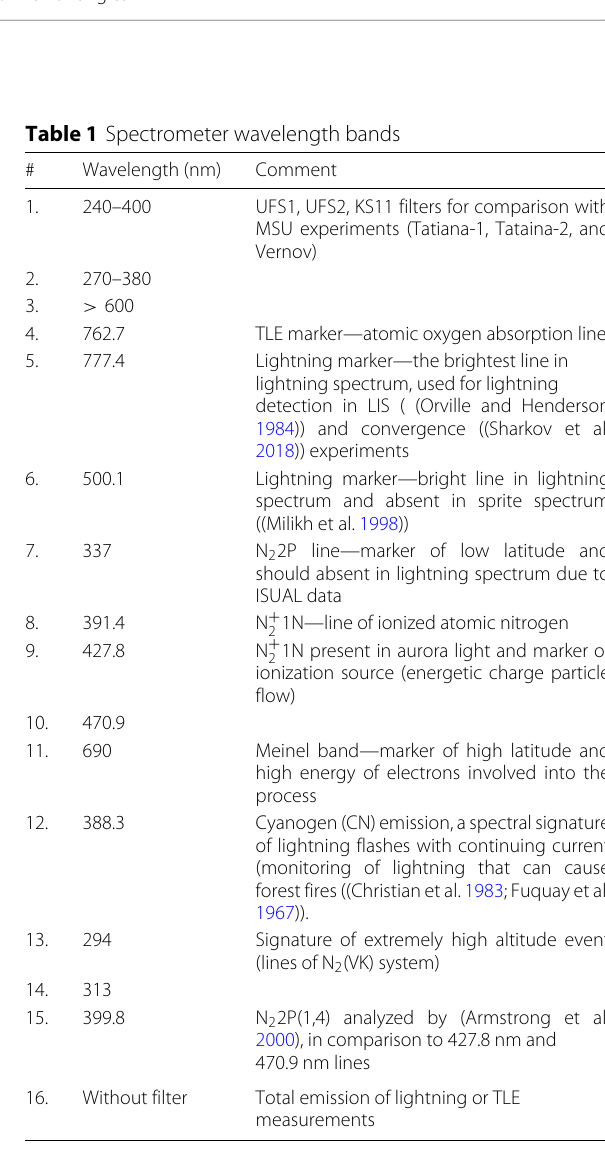
Fig. 7 Ray tracing (left) and image on the focal plane (right) for 0 ◦ ,4 ◦ ,8 ◦ ,9 ◦ zenith